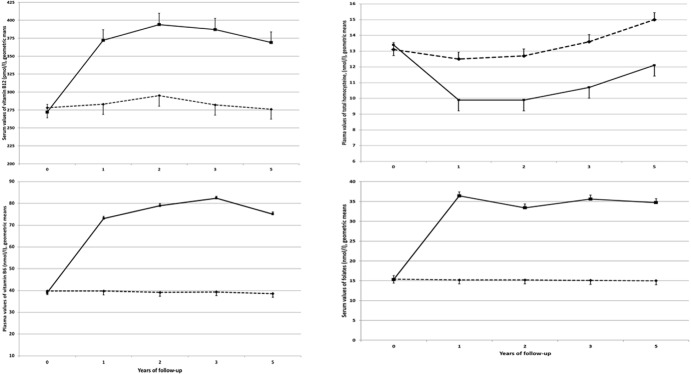
Evolution of the adjusted geometric mean plasma or serum values of vitamin B6 (with adjustment for sex, baseline age, plasma creatinine, tHcy and folate), folate (with adjustment for sex, baseline age, MTHFR genotype, tHcy and vitamin B6 and vitamin B12), vitamin B12 (with adjustment for sex, baseline age, tHcy and folate) and tHcy (with adjustment for sex, plasma creatinine, type of prevalent CVD, MTHFR genotype, vitamin B6, vitamin B12 and folate) from baseline through the 4.7y of follow-up, according to supplementation group.Approximately half of patients not supplemented with B-vitamins and half of patients supplemented with B-vitamins were supplemented with n-3 fatty acids. The groups were merged because the latter supplementation did not interact with B-vitamin supplementation. The SU.FOL.OM3 trial (2003–2009).